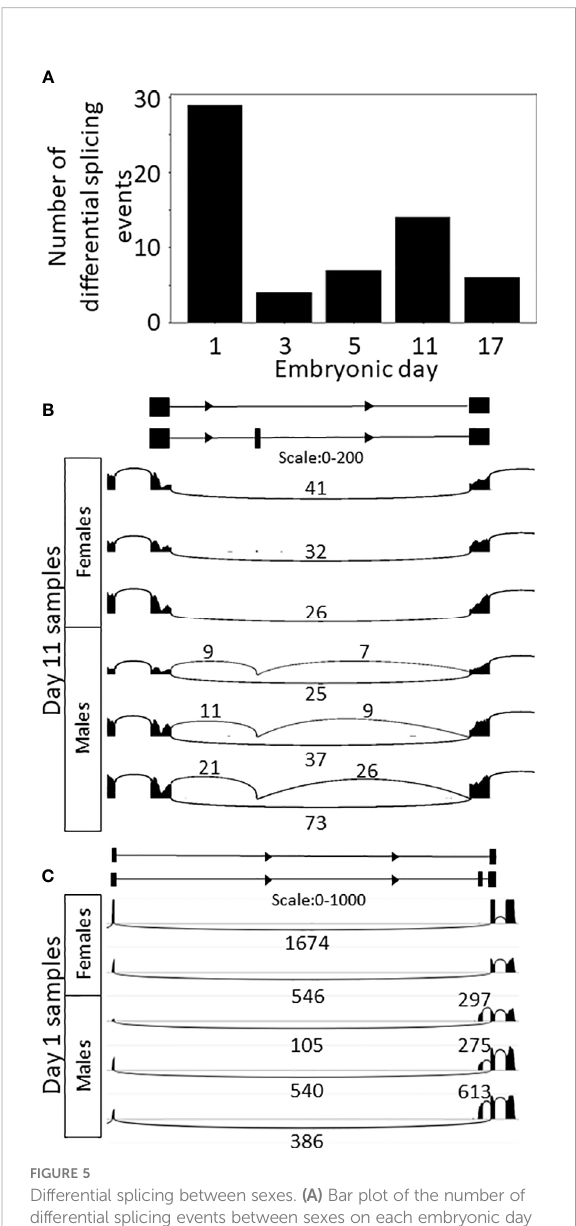
FIGURE 5 Differential splicing between sexes. (A) Bar plot of the number of differential splicing events between sexes on each embryonic day sampled. (B) Sashimi plot of skipped exon in gene g44510 in samples of 11-day-old embryos. The inclusive transcript (the bottom one in the diagram) is speci fi c to males. (C) Sashimi plot of alternative fi rst exon in g10657 in samples of one-day-old embryos. The bottom transcript in the diagram is speci fi c to males.